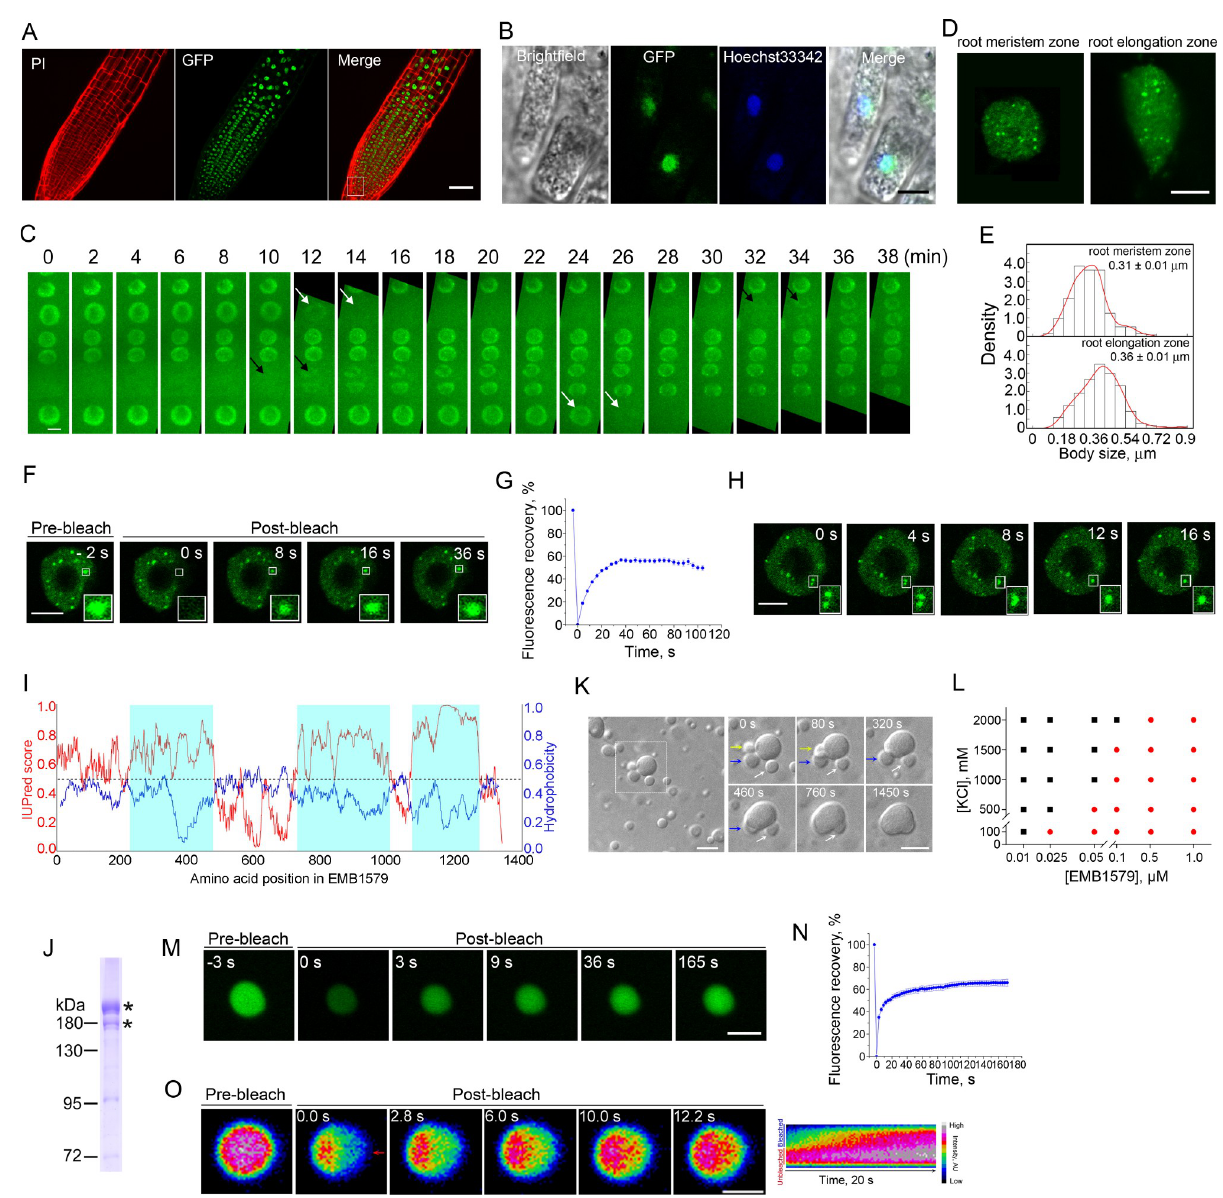
Fig 2. EMB1579 forms dynamic bodies in the nucleus of Arabidopsis root cells and undergoes rapid phase separation in vitro. ( A ) Micrographs of Arabidopsis primary root from pCAMBIA1301-proEMB1579::gEMB1579-TGFP; emb1579 plants. Root cells were revealed by staining with PI. Bar = 50 μ m. ( B ) Micrographs of Arabidopsis root cells showing the subcellular localization of EMB1579. Nuclei were stained with Hoechst 33342. Bar = 5 μ m. ( C ) Time-lapse images of root cells from pCAMBIA1301-proEMB1579::gEMB1579-TGFP; emb1579 . White arrows indicate the time points that EMB1579 starts to disappear from the nucleus, whereas black arrows indicate the time points that EMB1579 starts to appear in the nucleus. Bar = 5 μ m. ( D ) EMB1579 forms bodies within the nucleus of Arabidopsis root cells from the meristem zone and the elongation zone. Bar = 5 μ m. ( E ) Histograms of size distribution of EMB1579 bodies in the nucleus from cells in the root meristem zone and the elongation zone. More than 200 bodies were measured in at least 12 nuclei. The average values are presented as mean ± s.e.m. Numerical data underlying this panel are available in S1 Data. ( F ) Images of an Arabidopsis nucleus before and after bleaching. The photobleached region is boxed. Bar = 5 μ m. ( G ) Plot of fluorescence intensity before and after photobleaching. The blue curve represents the average value of fluorescence intensity of 18 bodies from 10 seedlings. All data are presented as mean ± s.e.m. Numerical data underlying this panel are available in S1 Data. ( H ) Images of an Arabidopsis nucleus showing the fusion of two EMB1579 bodies. Boxed region indicates two bodies that undergo fusion. Bar = 5 μ m. ( I ) Analysis of the intrinsic disorder tendency and hydropathicity of the full-length EMB1579 protein. The intrinsic disorder (red line) was analyzed with IUPred2A. The scores are assigned between 0 and 1, and a score above 0.5 indicates disorder. Three long stretches of disordered regions are shaded in light blue. The hydropathicity score (blue line) was determined with ExPASy, which used the Kyte-Doolittle scale of amino acid hydropathicity with a sliding window size of 21. The scores were normalized from 0 to 1. A score above 0.5 indicates hydrophobicity. Numerical data underlying this panel are available in S1 Data. ( J ) Purified